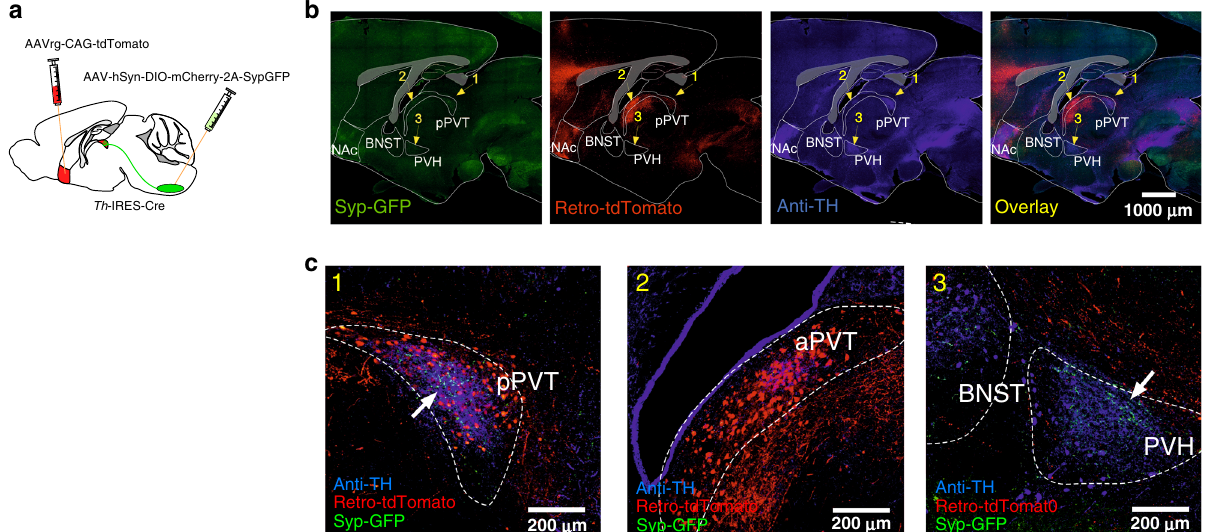
Fig. 1 Axonal projections from VLM CA neurons innervate the pPVT. a Schematic of virus injections strategy used to examine putative forebrain areas that had robust axonal inputs of VLM CA neurons and that project to the NAc. b Representative images of a sagittal brain slice showing the distribution of VLM CA projections, NAc-projecting neurons (Retro-tdTomato) and TH immunoreactivity (anti-TH) across various forebrain regions. c Representative images showing magni fi cations of the areas depicted in b , namely the pPVT (1), the aPVT (2), and the BNST/PVH region (3). White arrows depict regions of dense Syp-GFP